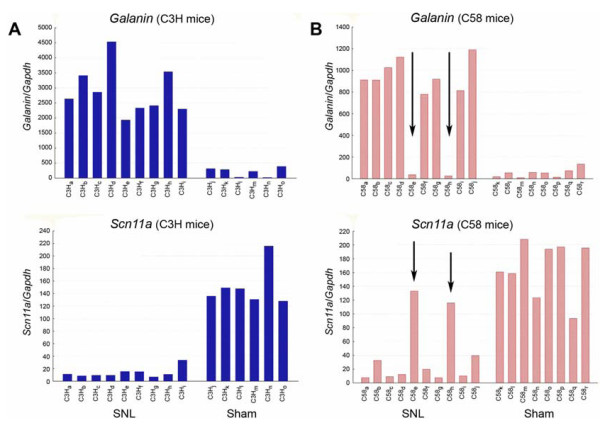
Galanin is up-regulated and Scn11a is down-regulated following spinal nerve ligation (SNL). Gene expression, plotted in relation to that of the stable housekeeping gene Gapdh, was assessed using TaqMan analysis 3 days following L5 SNL. Expression profiles for both genes are shown for individual mice of the A, C3H strain (labelled C3Ha-o) and B, C58 strain (labelled C58a-r). Arrows in B, indicate two outlier mice in which expression levels of both Galanin and Scn11a correspond to sham operated animals, suggesting that spinal nerve injury had not been carried out adequately.